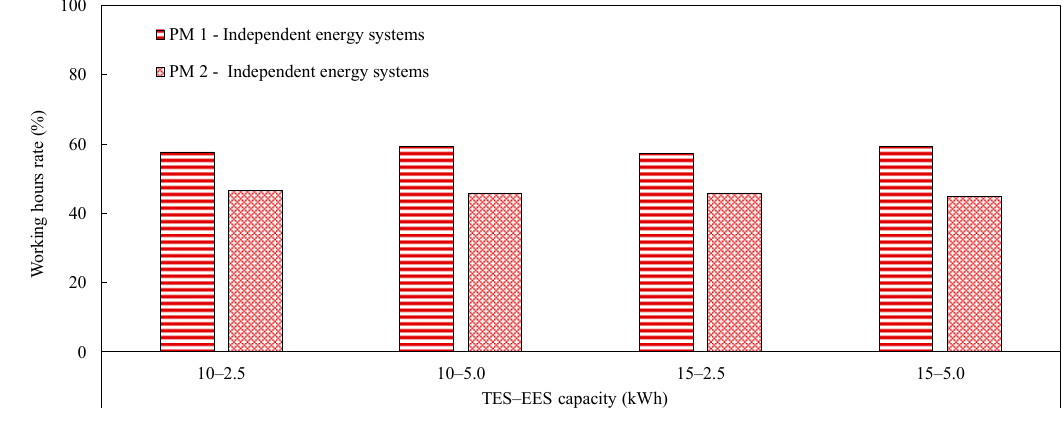
Figure 7. Rate of PM working hours with independent energy systems. Table 5. Primary energy consumption and rate of PM working hours.